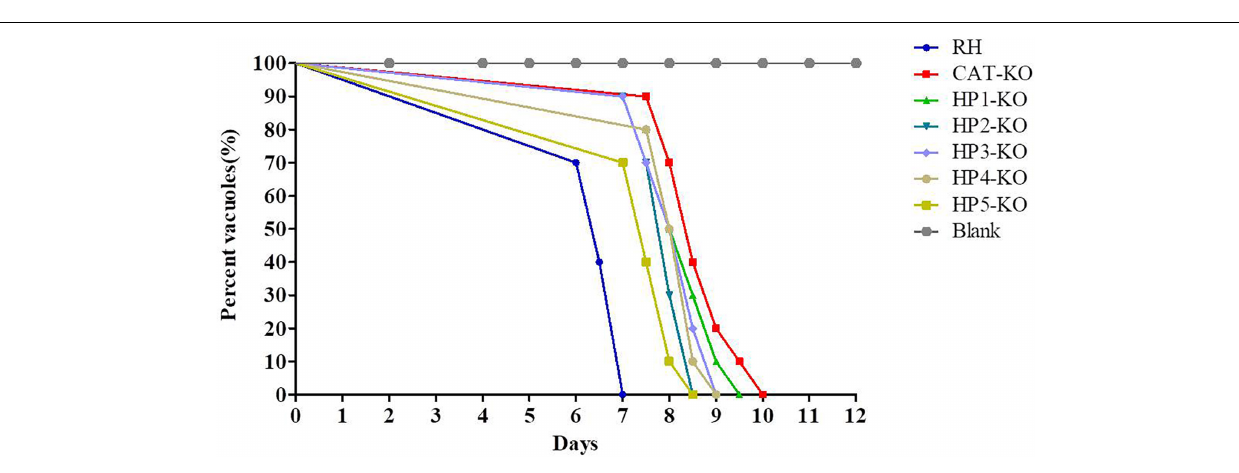
FIGURE 7 | Effect of hypothetic protein ( HP )-knockout (KO) on Toxoplasma gondii virulence. Kunming mice (10 mice/group) were intraperitoneally injected with 1 × 10 3 parasites of KO strains or RH strain of T. gondii , and the survival time of mice was monitored for 12